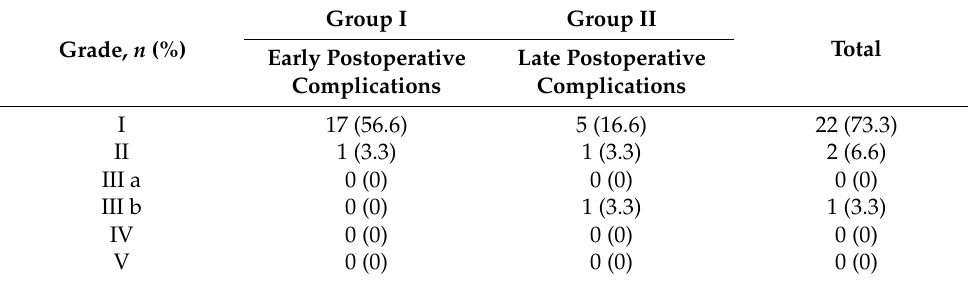
Table 4. Clavien–Dindo classification of surgical